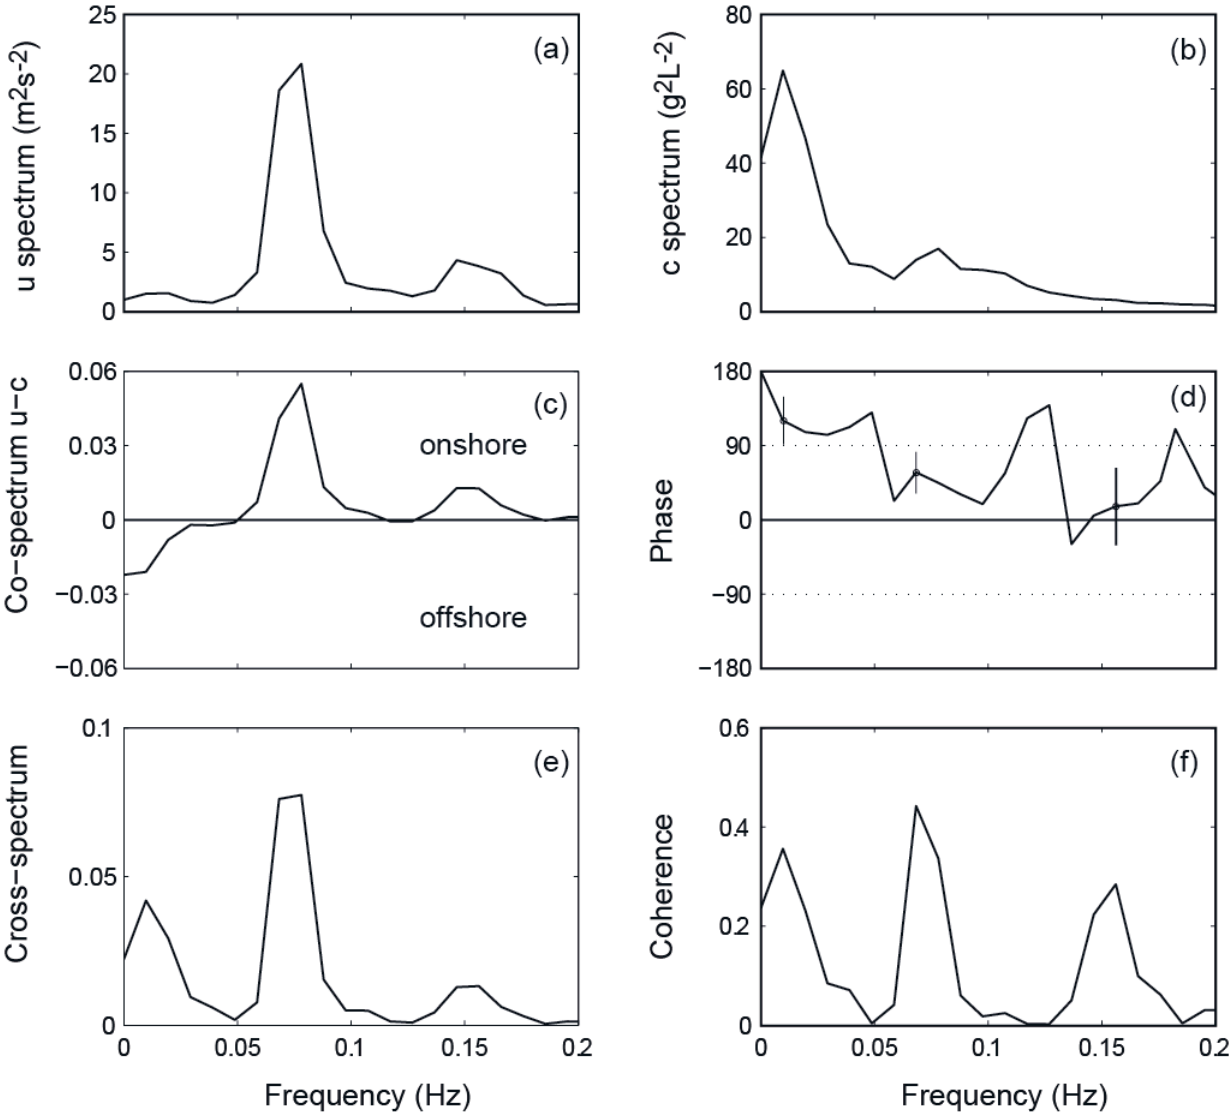
Figure 6. The results of spectral analysis between u and c . ( a ) Auto-spectrum of u ; ( b ) auto-spectrum of c ; ( c ) c - u co-spectrum in (gL − 1 ) (ms − 1 ) Hz − 1 ; ( d ) c - u phase spectrum; ( e ) c - u cross spectrum; ( f ) c - u coherence spectrum (just outside of the breaker line, over a flat bed, Mullaloo Beach, Western